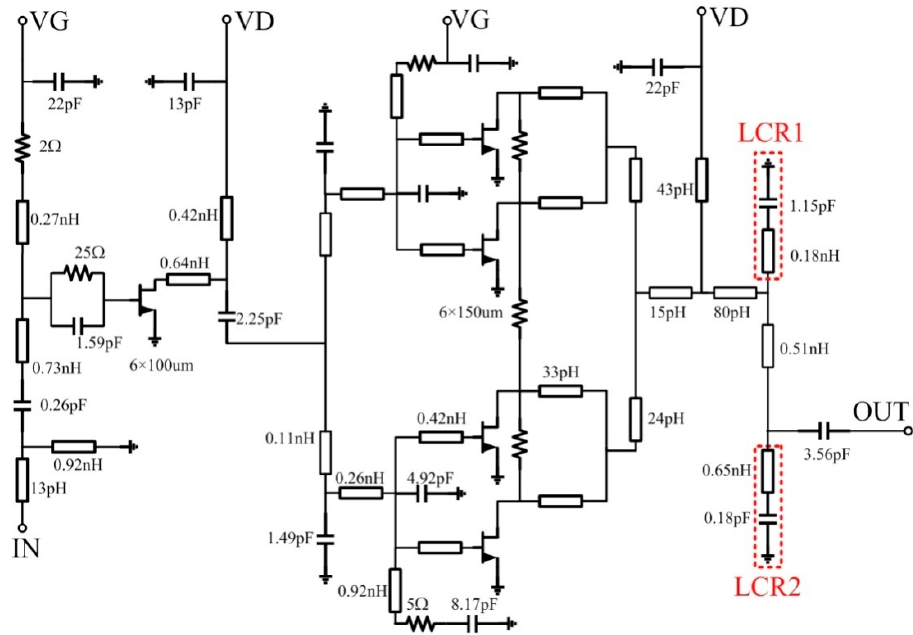
Figure 1. Schematic of the proposed C-band 30 W GaN PA MMIC with half-side circuit. To achieve high efficiency, fundamental and second harmonic impedance load pull simulations of the 6 × 150 μ m transistor were performed, with the goal of obtaining optimal impedance at a fundamental and second harmonic frequency, as shown in Figure 2. All the eight 6 × 150 µ m output stage transistors were operated in class AB bias condition, with a drain voltage of 28 V and a gate voltage of − 2.2 V. The static current I ds of the PA MMIC